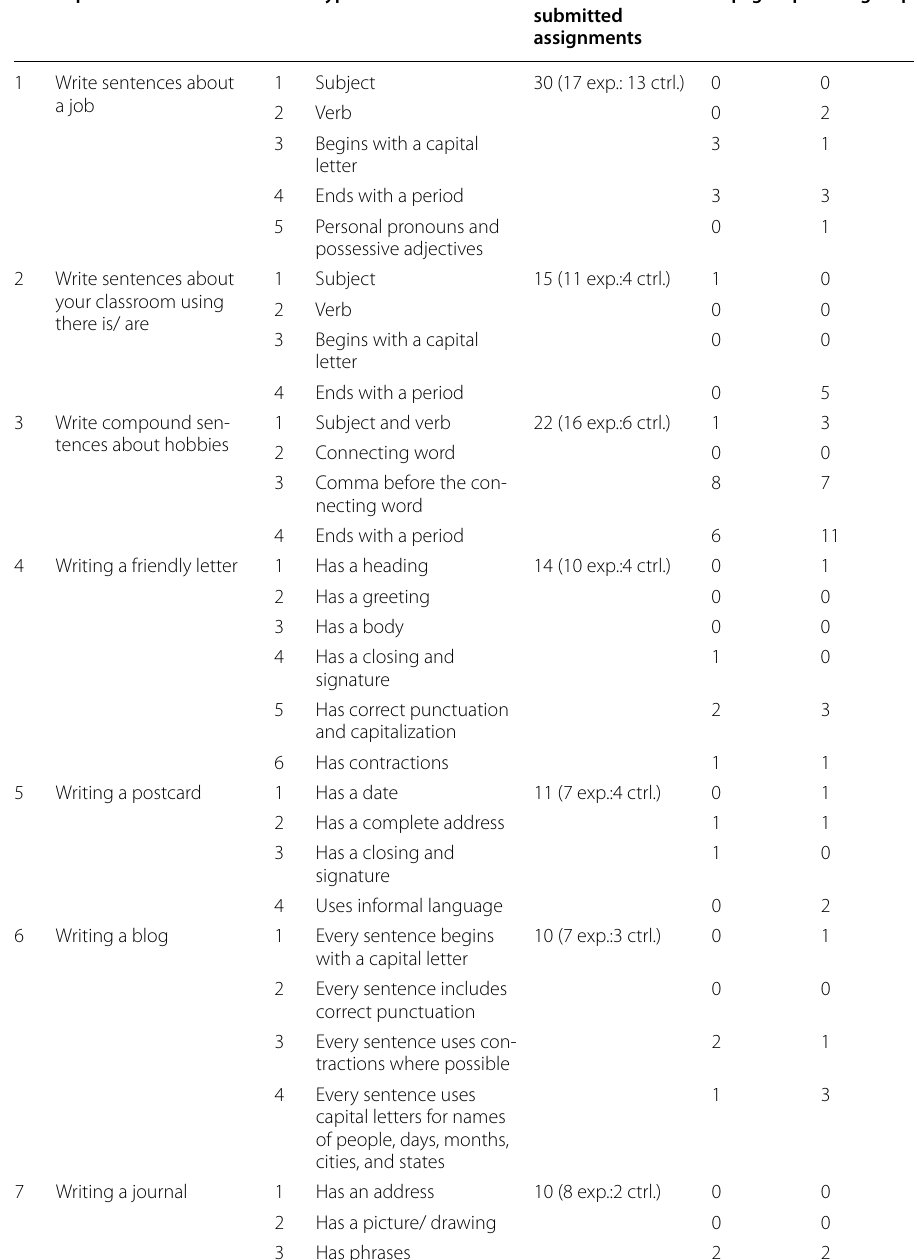
Table 3 Coding sheet of the participants’ EFL writing portfolios No Topics No Types of mistakes No of the